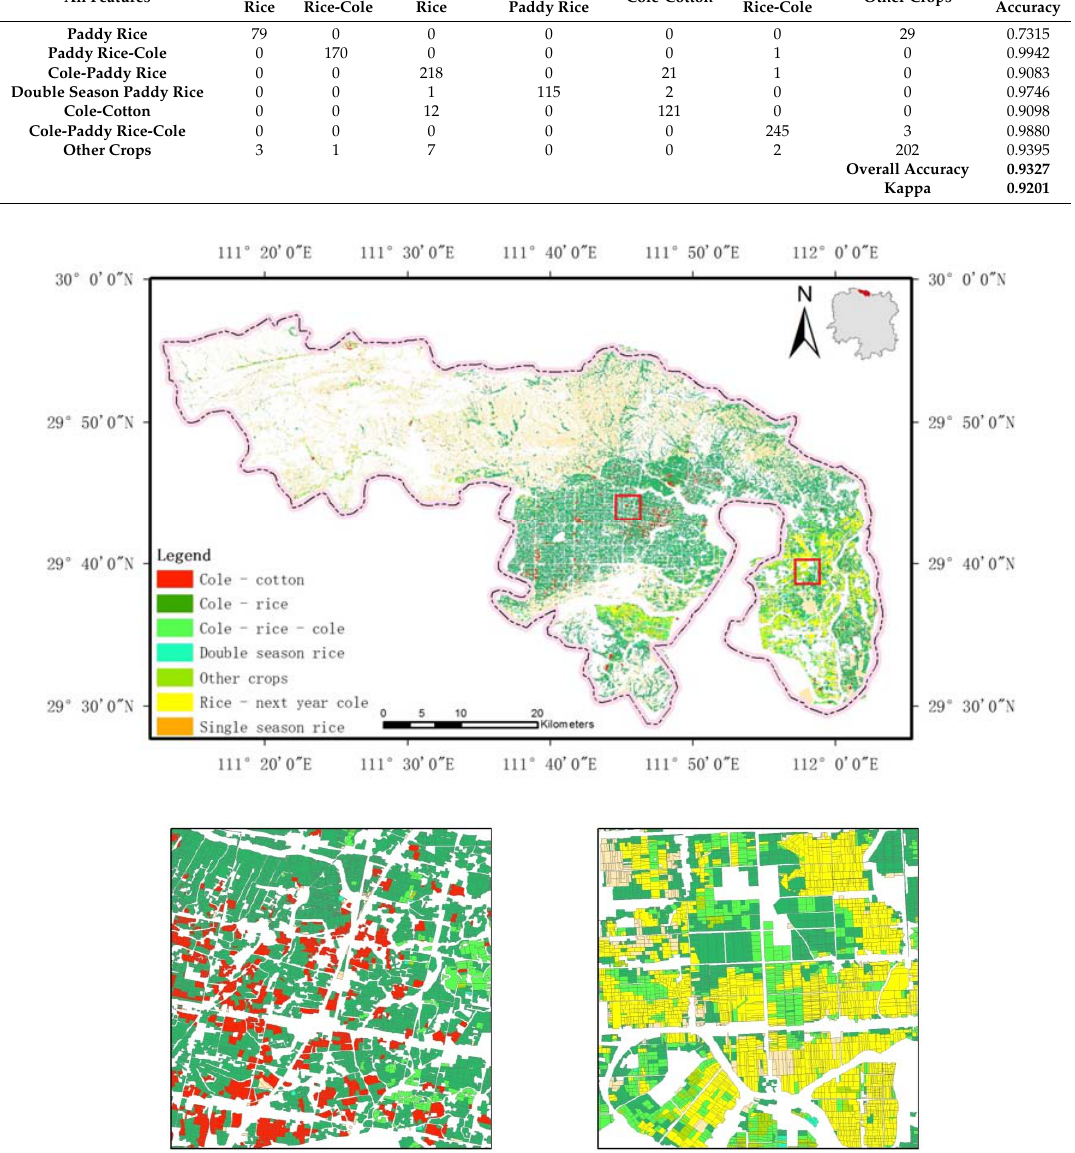
Figure 11. Field ‐ based crop type identification. Figure 11. Field-based crop type